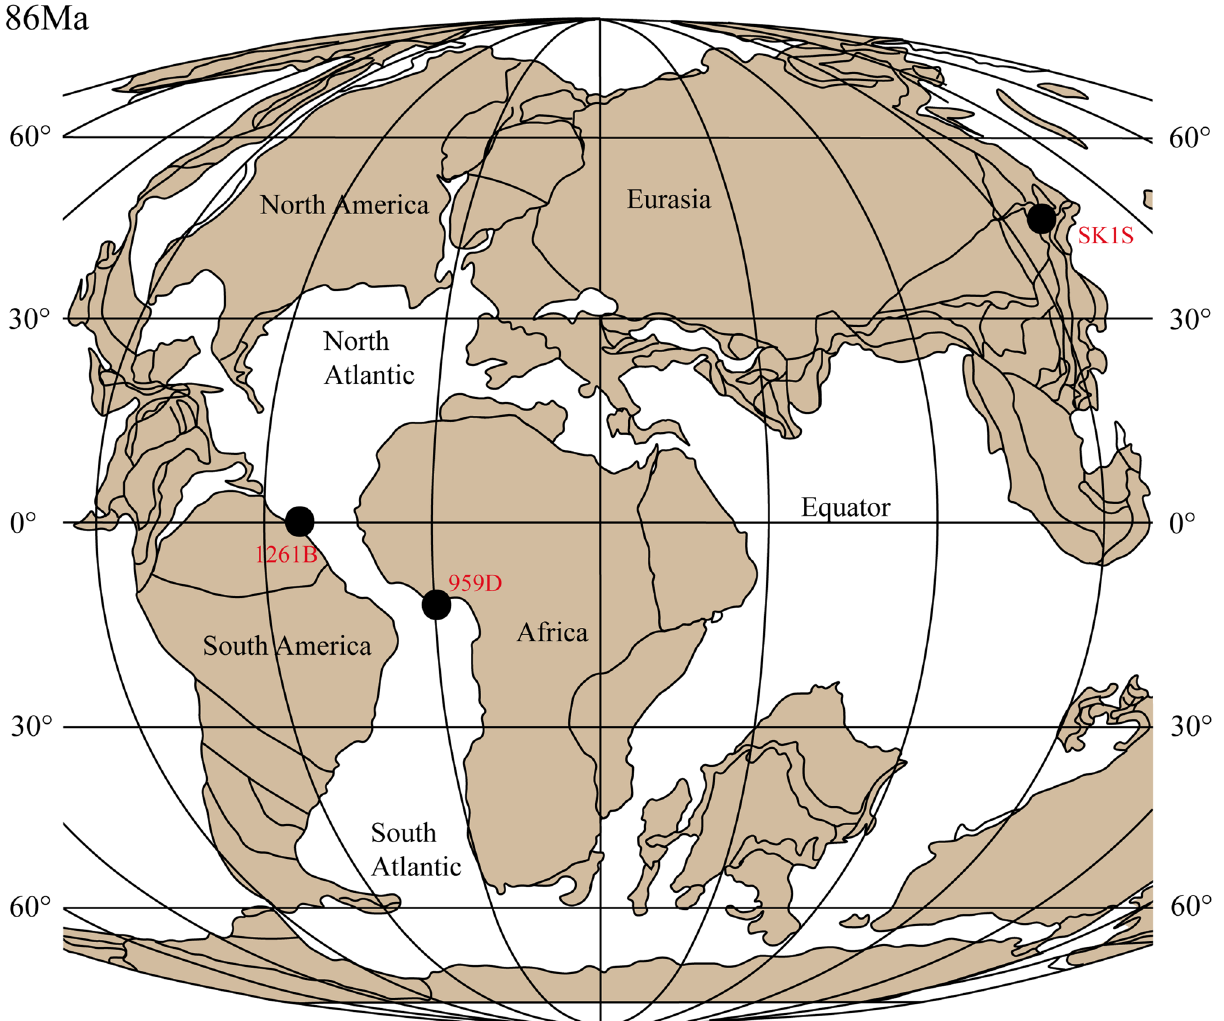
Figure 1. Site locations for the studied Coniacian–Santonian OAE in northeastern Asia, northwestern Africa and off south America (plate tectonic map of the Late Cretaceous for 86 Ma modified from Wagreich 56 ). Location of sites 959D (Deep Ivorian Basin) and 1261B (Demerara Rise) are from Wagreich 56 ; location of SK1S (Songliao Basin) is from Wang et al. 26